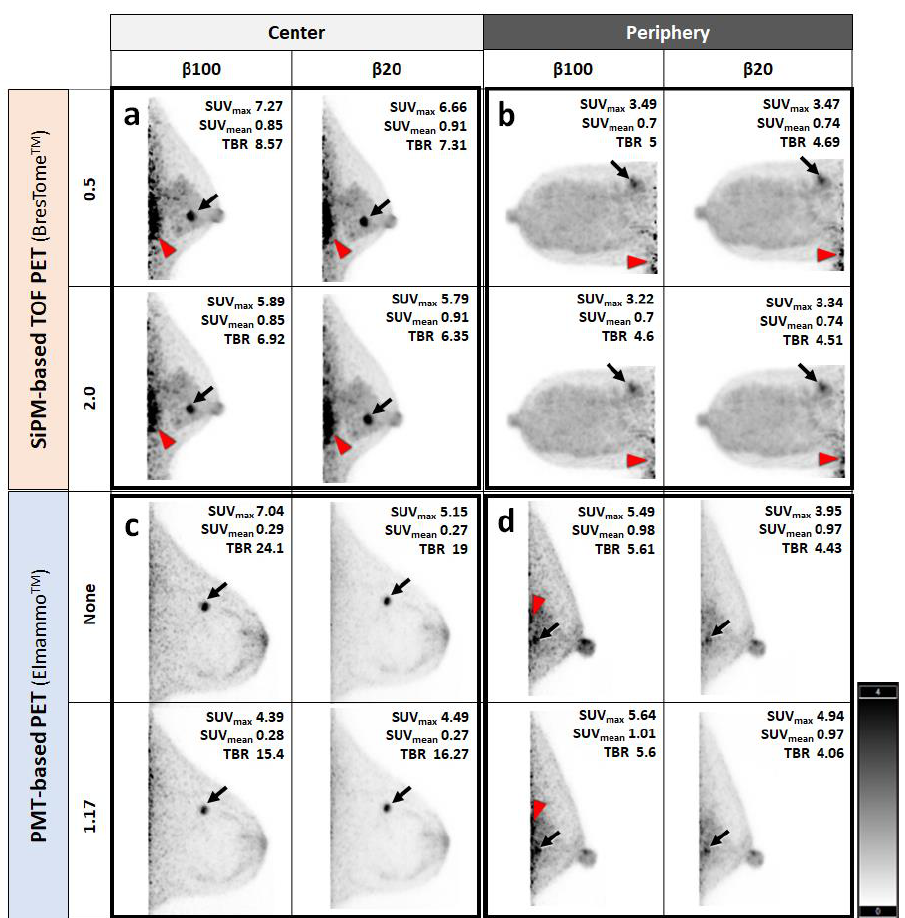
Figure 7. Clinical images of breast cancer (BC) patients scanned with the two organ-specific PET scanners. Medio-lateral maximum intensity projection images of BC near the nipple ( a , c ) or near the chest wall ( b , d ) scanned with SiPM-based TOF-PET ( a , b ) or PMT-based TOF-PET ( c , d ). All images presented invasive carcinoma (T1) on an inverted grayscale in a standardized uptake range of 0–4. Small breast cancers were clearly visualized ( arrows ), and noise on the chest wall side was noticeable in some cases ( arrowheads ). ( a ) Left breast of a 56-year-old woman with invasive ductal carcinoma (luminal A). ( b ) Right breast of a 73-year-old woman with invasive ductal carcinoma (HER-2-rich). ( c ) Left breast of a 59-year-old woman with invasive ductal carcinoma (luminal A). ( d ) Left breast of a 48-year-old woman with ductal carcinoma in situ (luminal B).